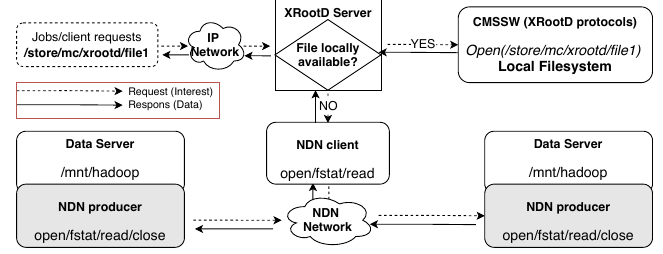
Figure 1: XRootD NDN based Open Storage System plug-in